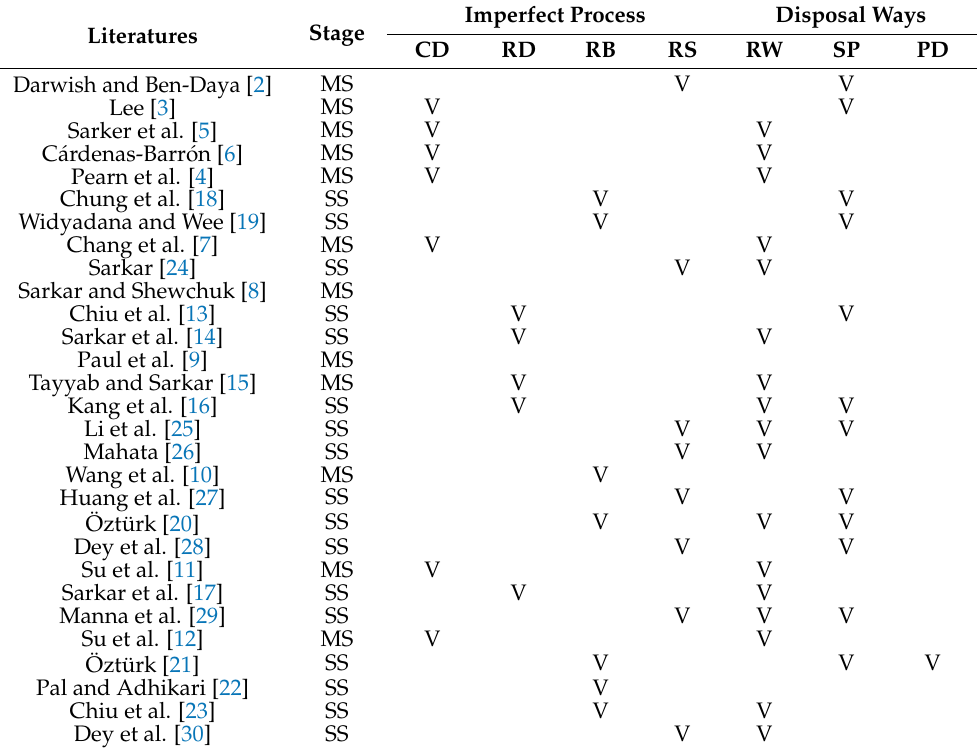
Table 1. A brief comparison of imperfect production systems by